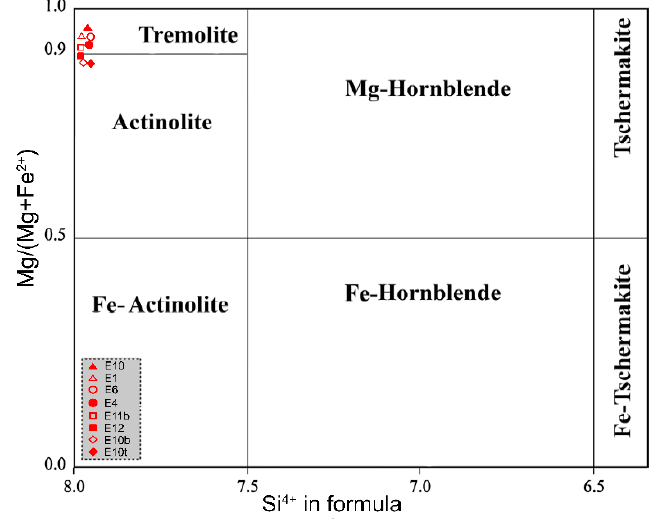
Figure 6. Amphibole classification diagram (after [19]).